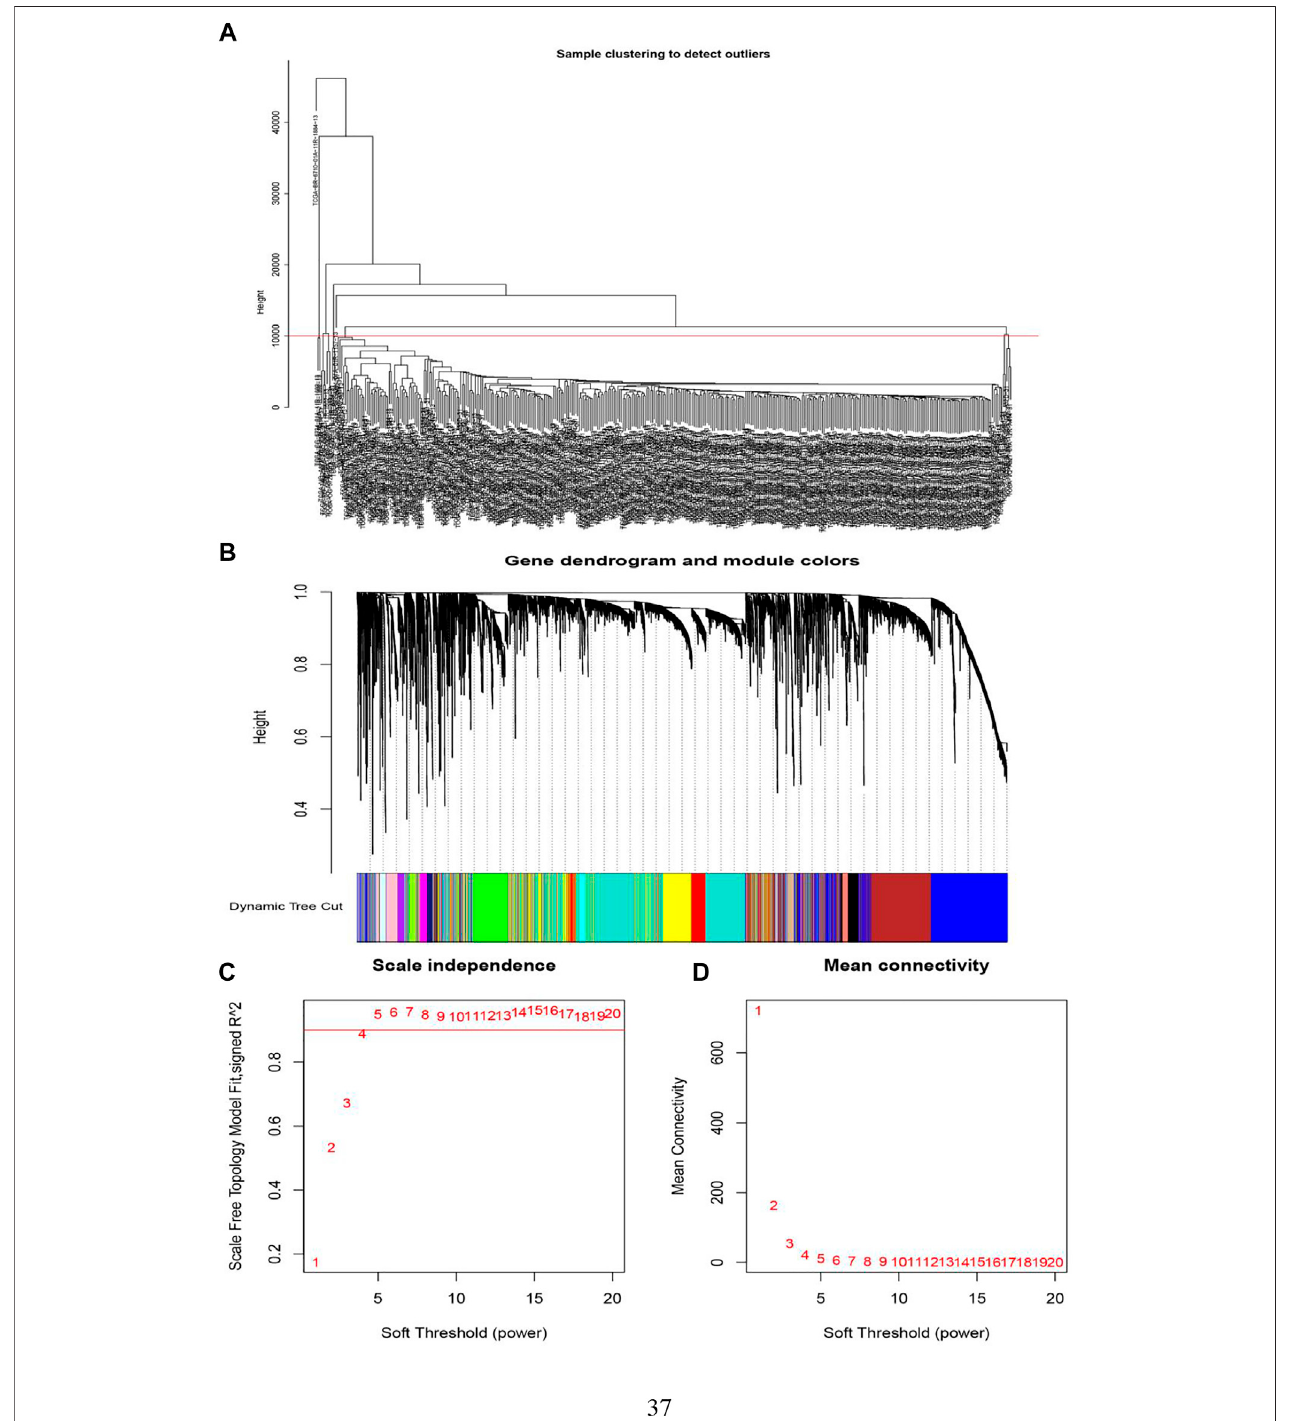
FIGURE4| Thedeterminationofsoftthresholdpower. (A) Screeningoutthesampleswithoutlierexpression. (B) Byhierarchicalclustering,genesweredividedinto different modules. Different colors equal to different modules. (C) Scale-free fi t index analysis of 1 – 20 soft threshold power ( β ).The horizontal axis was the soft threshold (power),andtheverticalaxiswastheevaluationparameter ofthescale-freenetwork.Thehigherthevalue,themorethenetworkconformstothenon-scalefeature(non- scale). (D) The average connectivity of soft threshold power was analyzed.